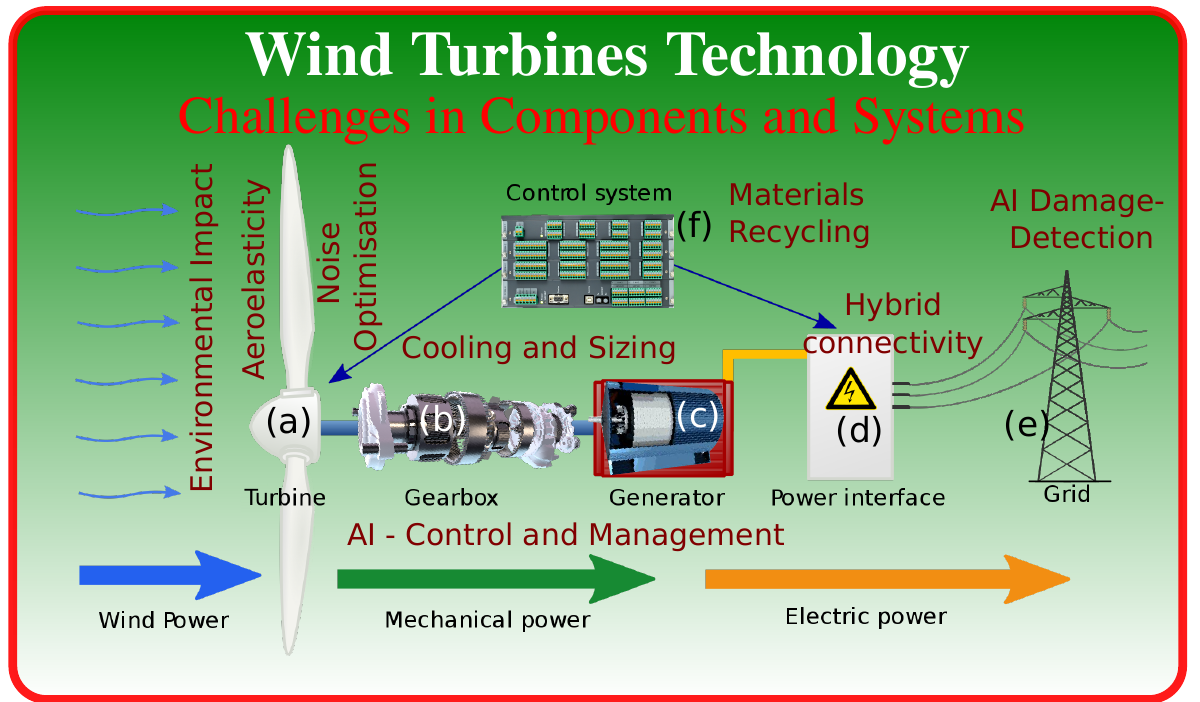
Figure 2. Major challenges in wind turbine technology. This includes aeroacoustic optimisation of turbine blades, efficient cooling and compact sizing of generators and gearbox systems, overall materials recycling, hybrid connectivity of power interfaces, AI control and management and AI and ML damage